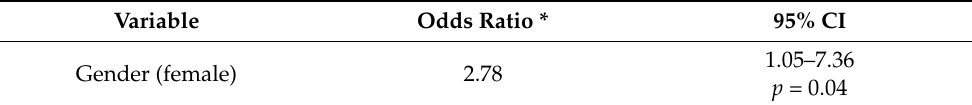
Table 5. Gender is a statistically significant predictor in the studied group of healthcare professionals influencing the risk of a high BDI